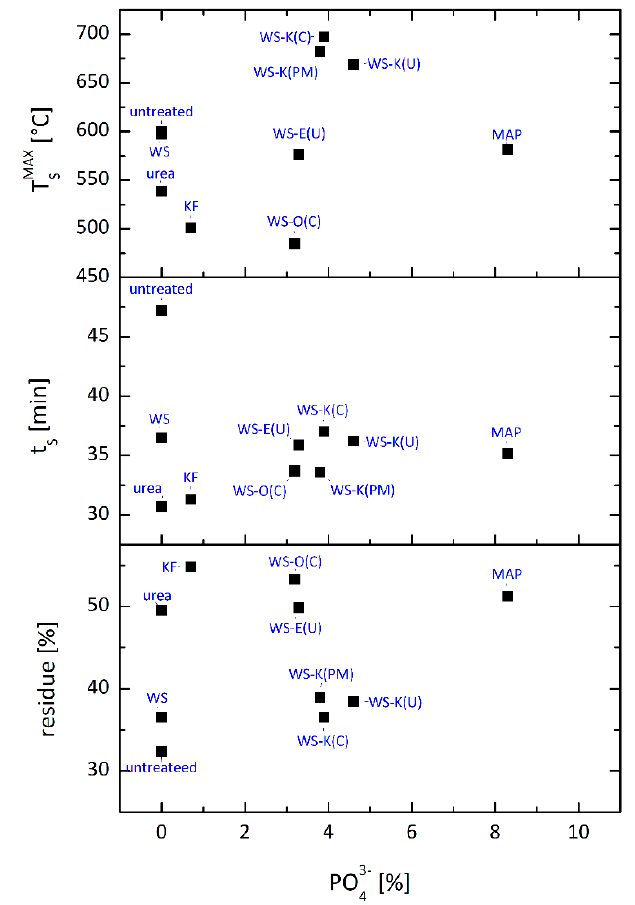
Figure 4. Residue, time (t S ) and maximum temperature (T SMAX ) from smoldering measurements of wood fibers with different additives depending on their phosphate content, additive content on fiber 10 wt.% (for detailed information see Table 3).